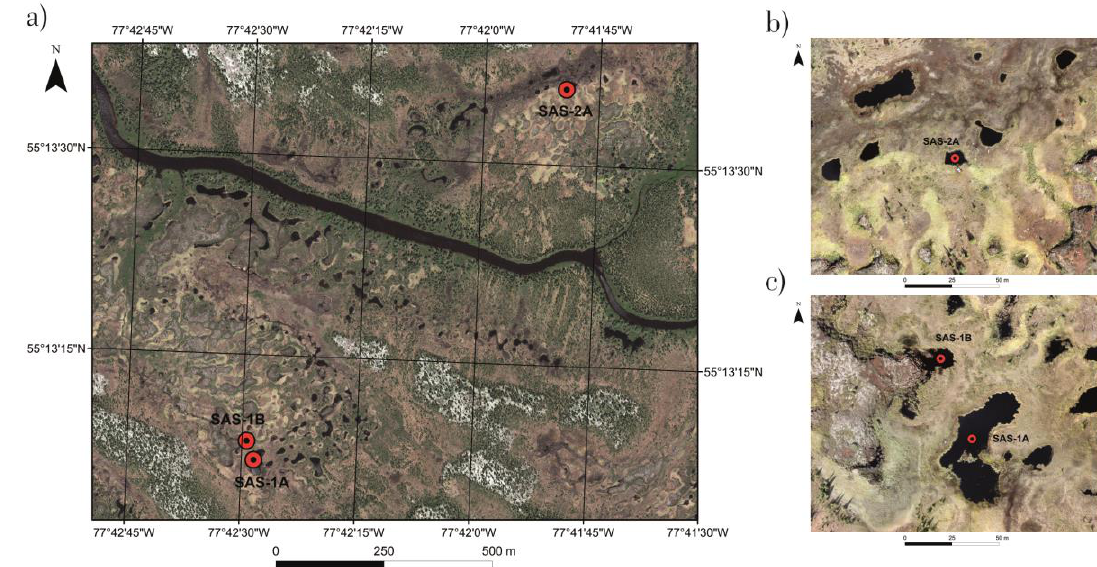
Figure 1. Regional ( a ) and detailed ( b , c ) location of lakes SAS-2A, SAS-1B and SAS-1A in the Sasapimakwananisikw (SAS) River valley, subarctic Québec, Canada. Source: Esri, DigitalGlobe, GeoEye, Earthstar Geographics, CNES/Airbus DS, USDA, USGS, AeroGRID, IGN, and the GIS User Community ( a ) and Unmanned Aerial System surveys from 1 September 2017 ( b , c ).